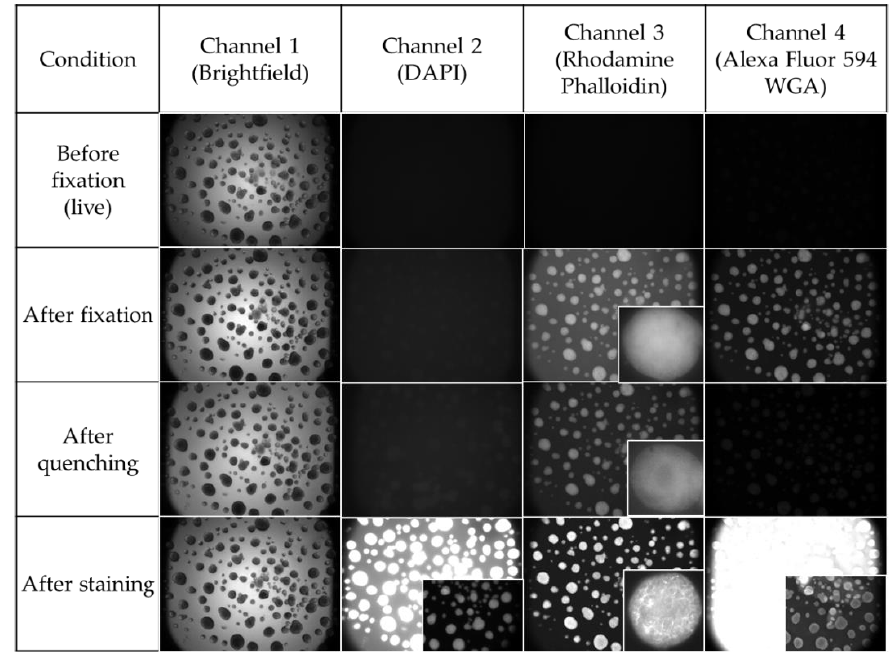
Figure 2. Induction of auto-fluorescence glutaraldehyde fixation and decrease of auto-fluorescence using sodium borohydride quenching at 0.2%. All large images (2.5×, Cytation 5) were taken with the same exposure time in each respective channel. DAPI and Alexa Fluor 594-WGA staining are over-saturated at high exposure times and small images show organoids at lower exposure time. Small images in channel 3 (20×, CellInsight CX7 LZR platform) show Rhodamine Phalloidin staining of F-actin structures that supersede the background fluorescence.